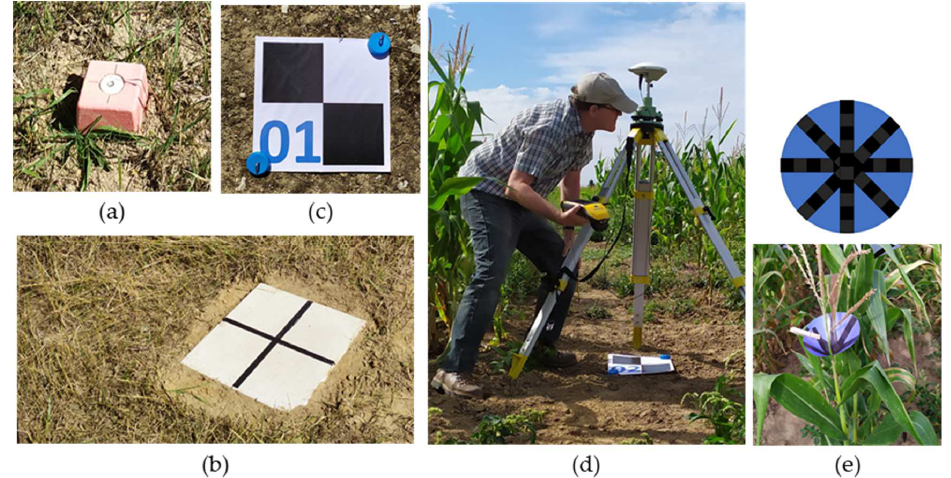
Figure 9. GCPs used for the study. ( a ) Surveyor’s terminal as a reference point for the DRTK-2 base station; ( b ) semi-buried permanent GCP; ( c ) cardboard target as temporary GCP; ( d ) Geo7x terminal